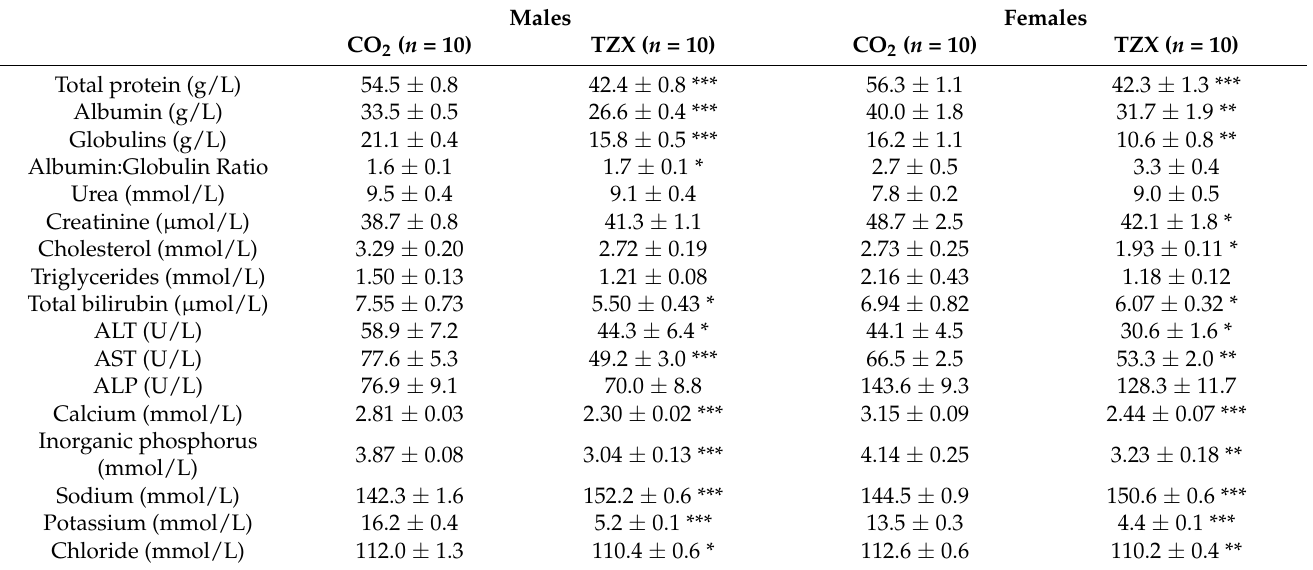
Table 1. Clinical biochemistry results for serum of CD-1 mice collected in 5 min after CO 2 inhalation or tiletamine–zolazepam–xylazine